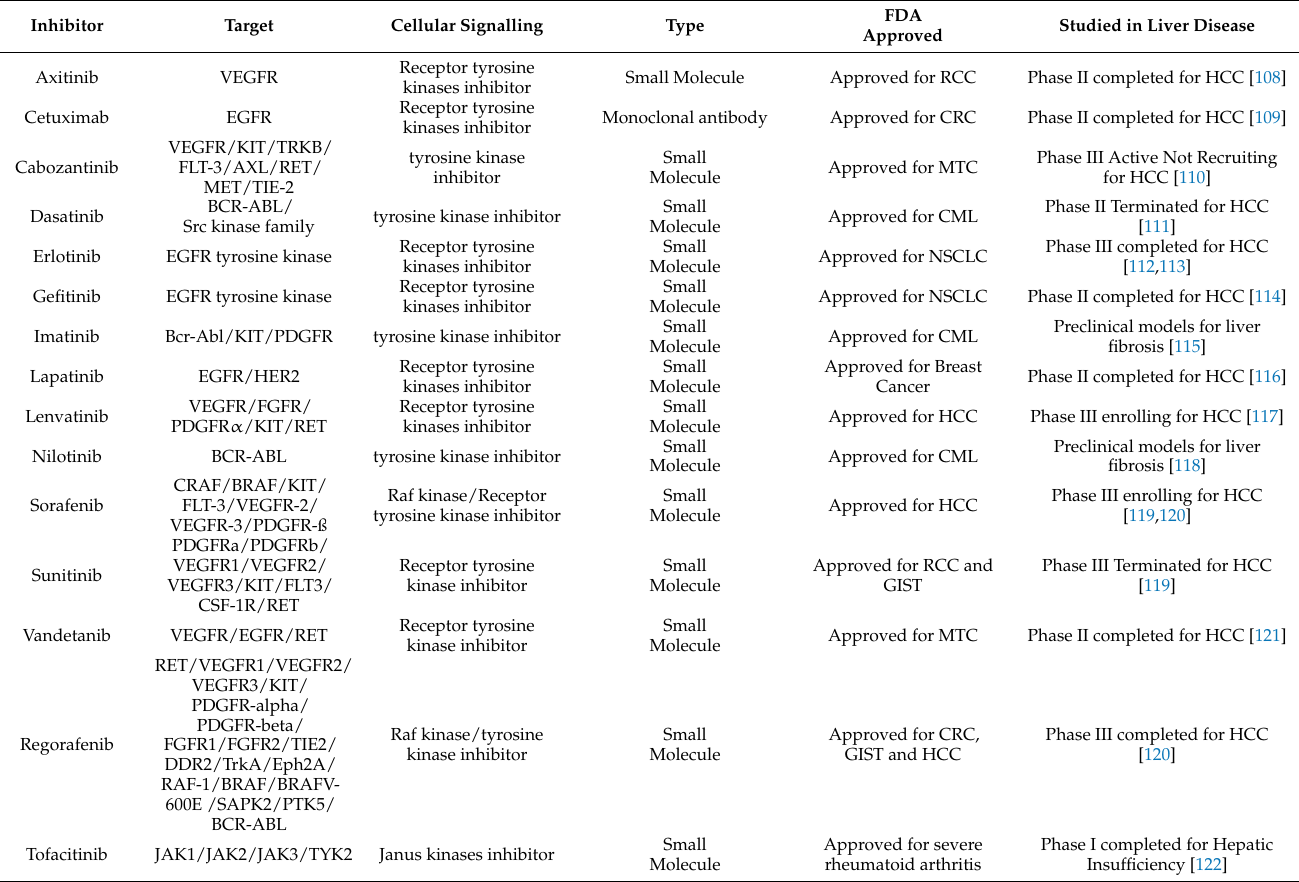
Table 1. Common inhibitors of kinases and their